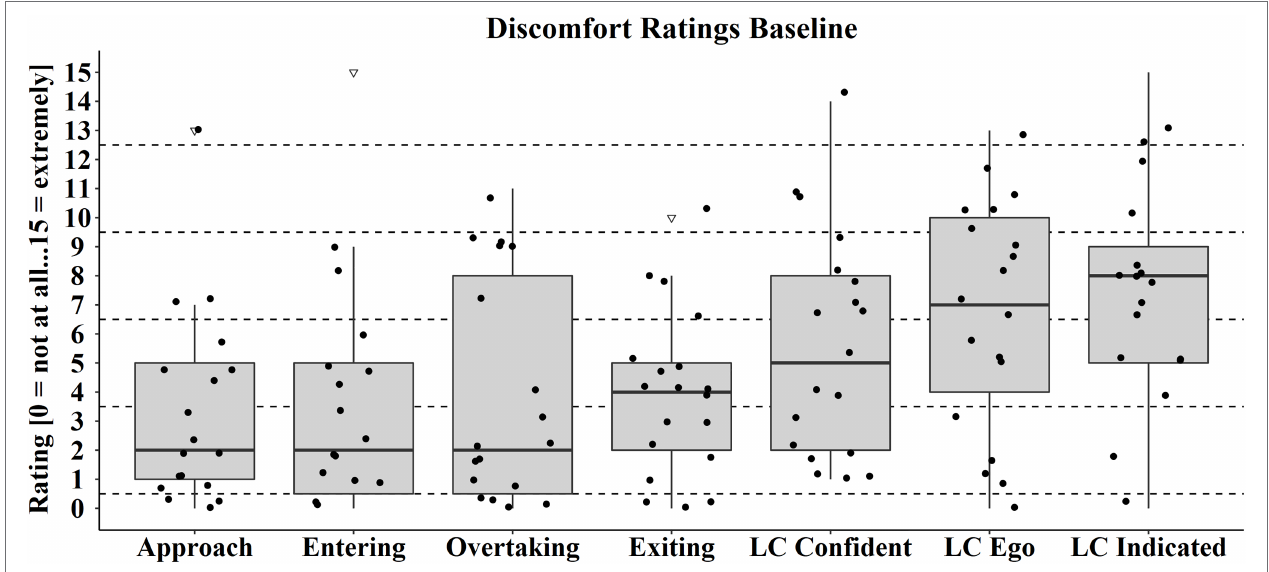
FIGURE 5 | Discomfort ratings for each situation in the baseline ride. The dots represent the individual discomfort ratings of each participant in the situations. Box range = Q1 to Q3. Whiskers = 1.5 *IQR.